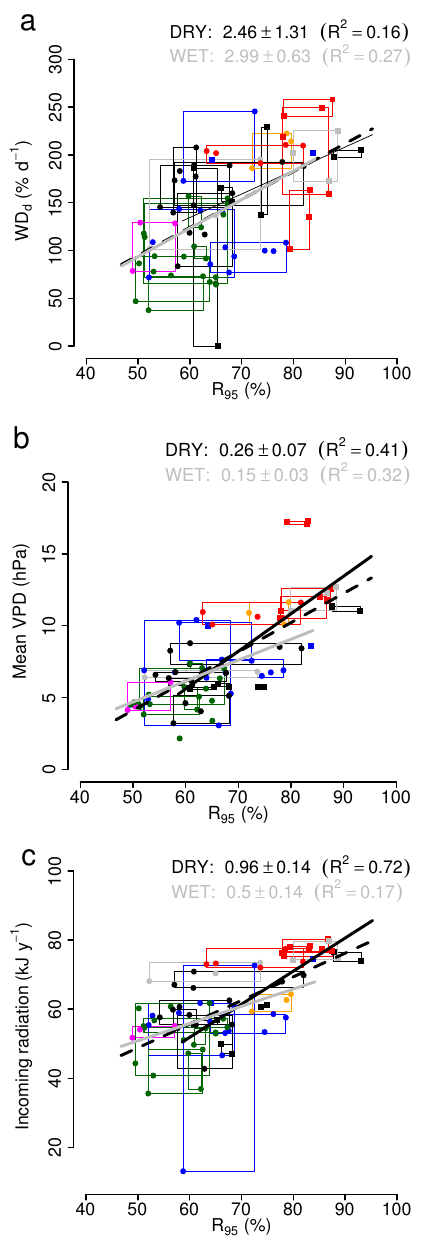
Fig. 6. Relationships between R 95 and (a) mean soil water deficit, (b) mean annual vapour pressure deficit, (c) total incoming radia- tion. Details as for Fig.